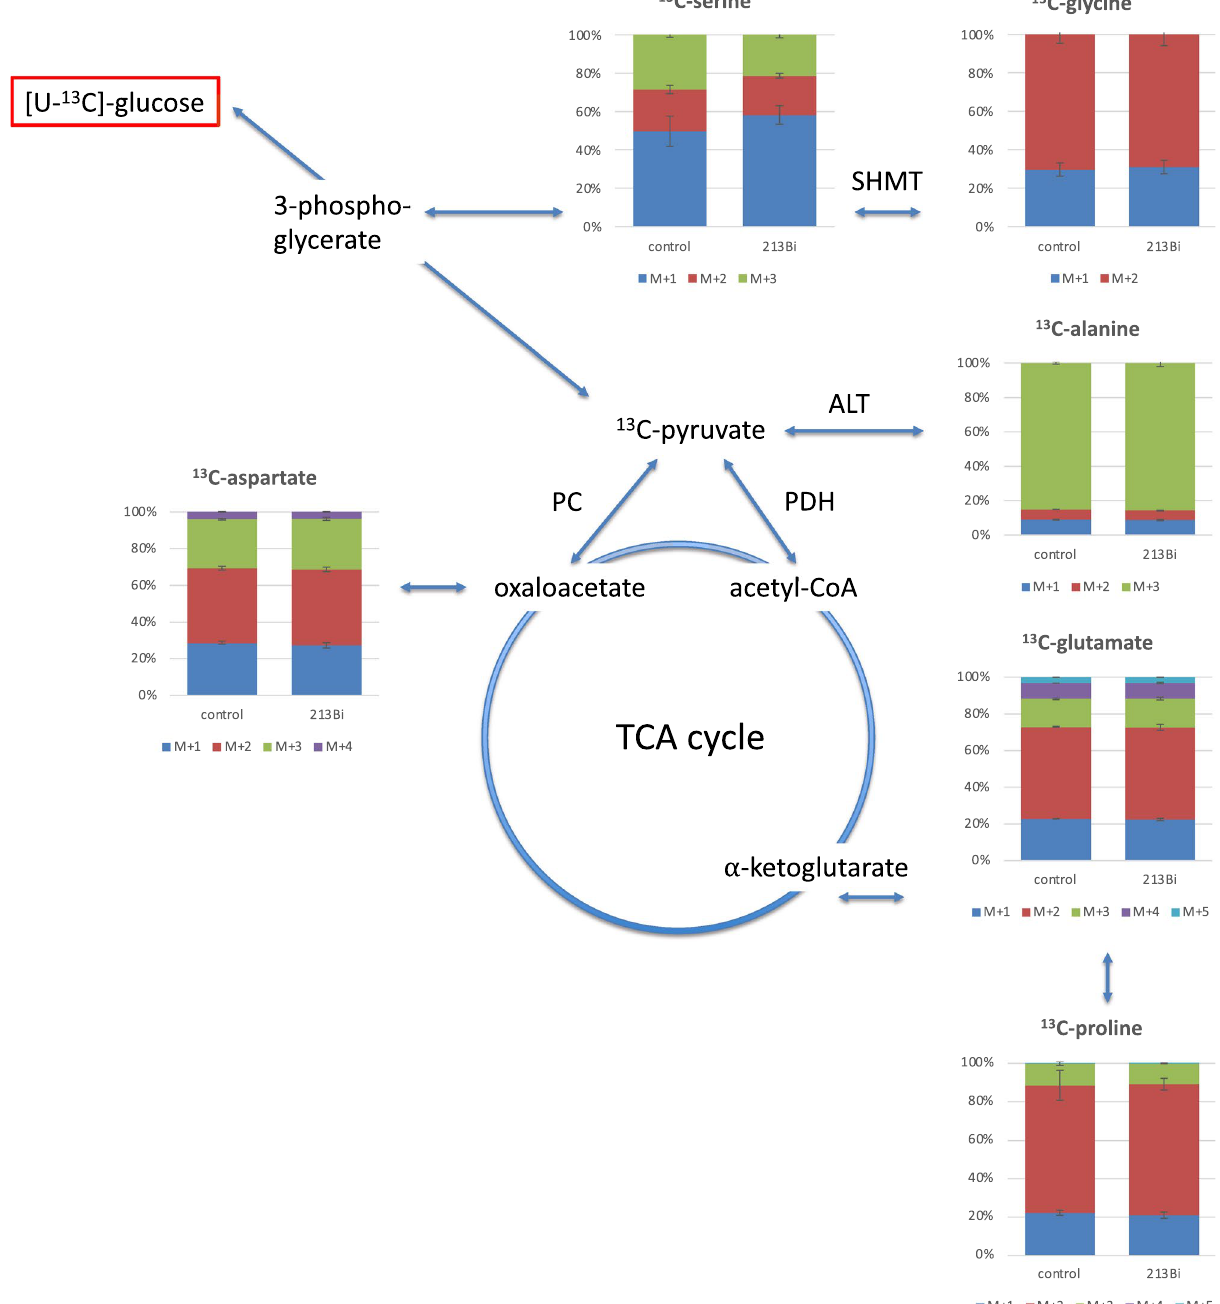
Figure 4. Isotopologue profiling with regard to 13 C in alanine, aspartate, glutamate, glycine, proline, and serine following incubation of LN18 cells with 213 Bi-anti-EGFR-MAb compared to untreated controls. As expected from the results shown in Fig. 2, isotopologue profiling did not reveal significant differences between 213 Bi-anti-EGFR-MAb treated and untreated LN18 cells, except for the serine isotopologue containing three 13 C-atoms (M + 3). However, the frequency of the different 13 C isotopologues was identical for all amino acids in both cell lines analyzed (EJ28Luc and LN18). For example, in proline consisting of five C-atoms, the most frequent isotopologues contained two 13 C-atoms and isotopologues with four or five 13 C atoms could not be detected in both cell lines. SHMT serine hydroxymethyl transferase, ALT alanine aminotransferase, PC pyruvate carboxylase, PDH pyruvate